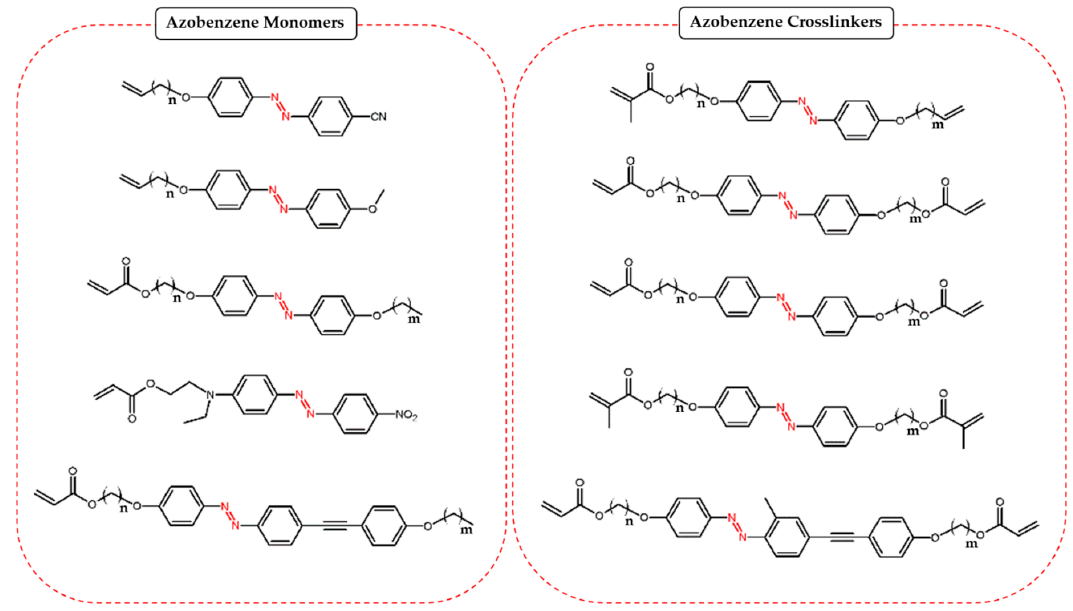
Figure 8. Partial list of chemical structures of azobenzene chromophore containing liquid crystalline (LC) materials (monomers and crosslinkers) utilized to prepare liquid crystalline polymers (LCPs) with polysiloxane and polyacrylate backbone [60,67–71].